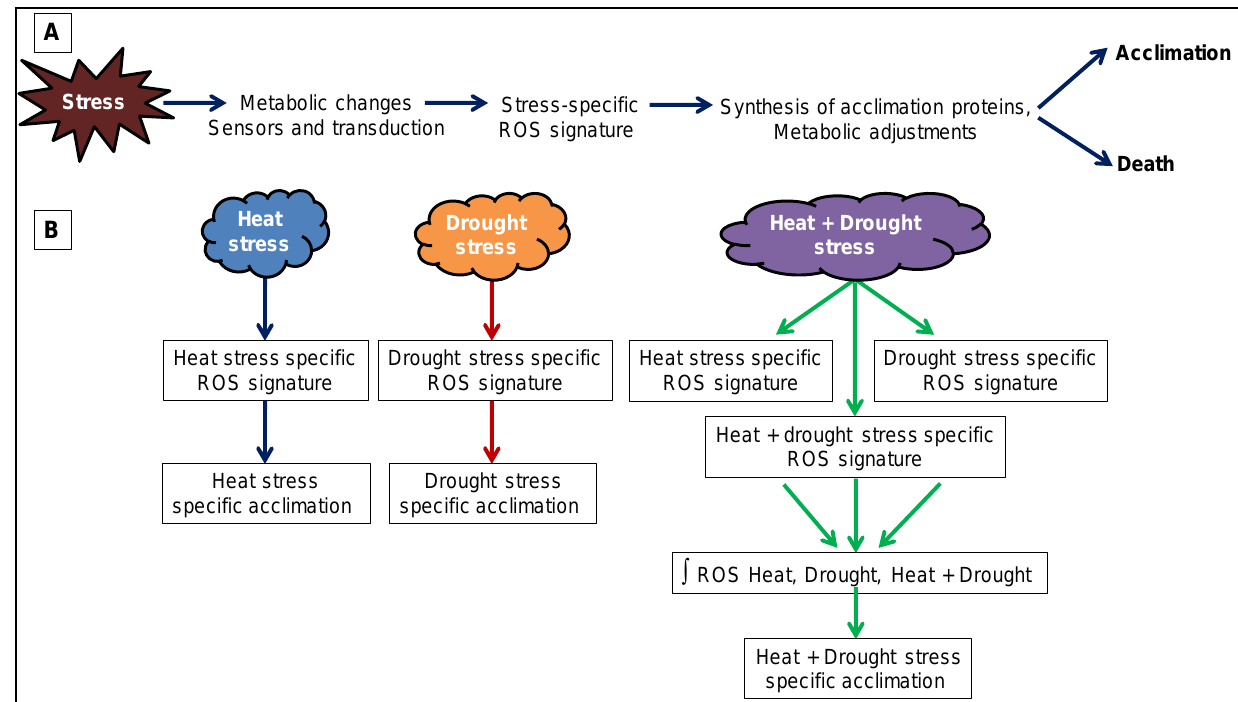
Figure 3. Reactive oxygen species (ROS) signature during abiotic stress combination. ( A ) Abiotic stress is shown to result in the formation of a ROS signature that mediates plant acclimation or cell death. ( B ) A combination of two different stresses (heat and drought stress) is shown to generate a ROS signature that is unique to the stress combination and is the result of combining three different ROS signature (ROS signature for heat stress, ROS signature for drought stress and ROS signature generated from the combination of heat + drought stress).